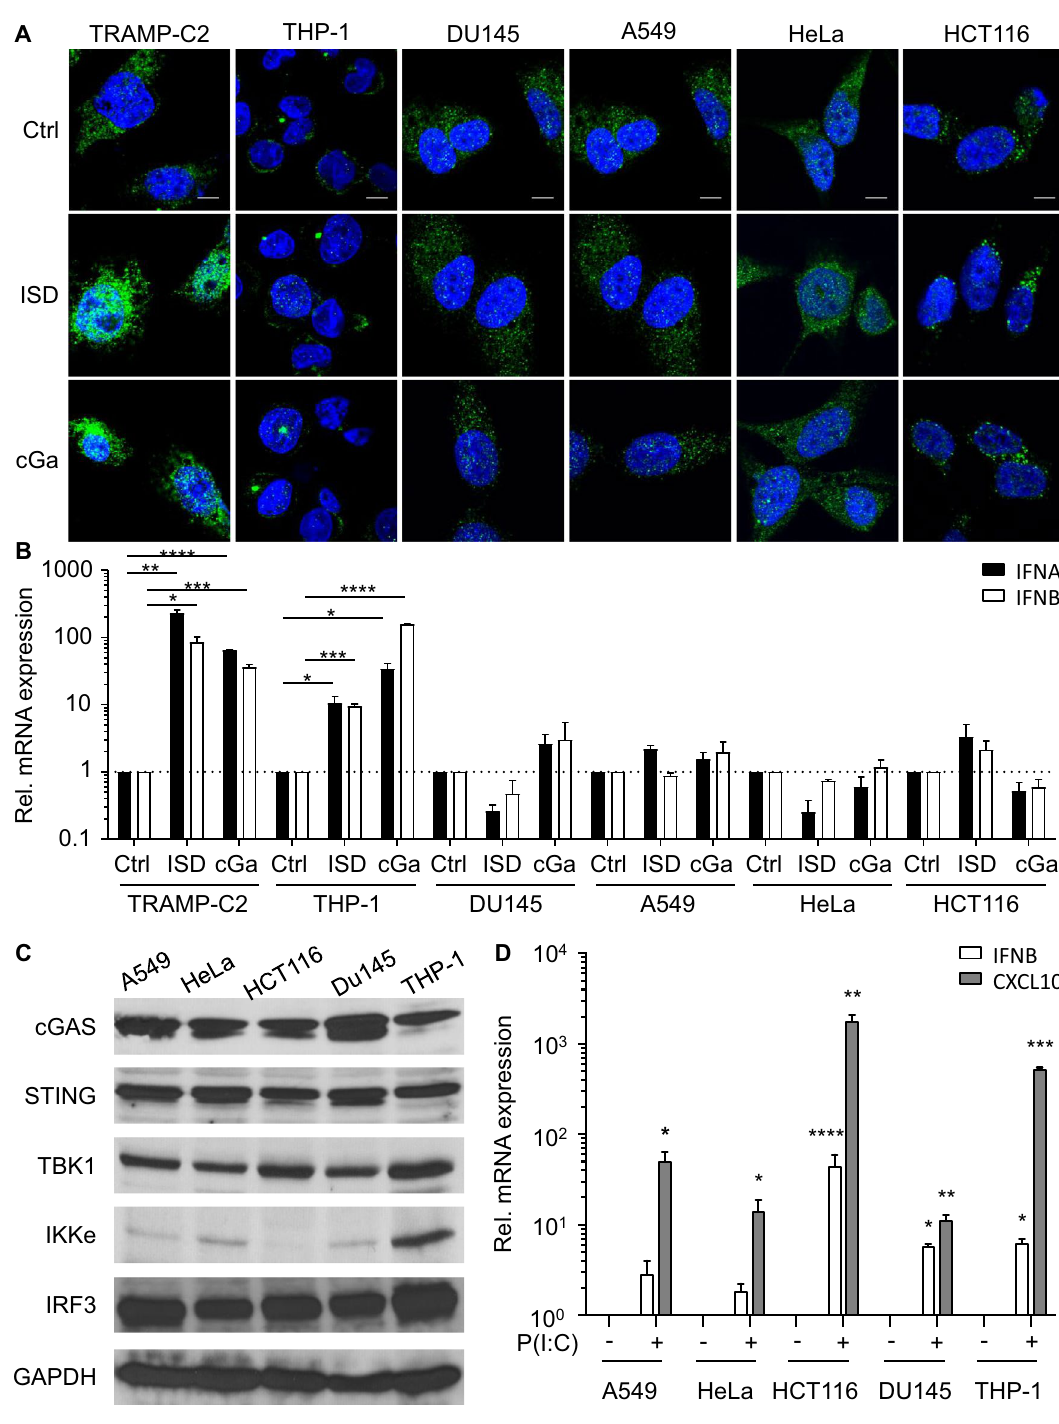
Figure 1. STING Signaling is Defective in the Majority of Tested Human Cancer Cell Lines. ( A ) Murine TRAMP-C2 prostate cancer cells, human THP-1 leukemia cells, human DU145 prostatic carcinoma cells, human A549 lung carcinoma cells, human HeLa cervical adenocarcinoma cells and human HCT116 colorectal carcinoma cells were treated with PBS (ctrl), 2 μg/ml ISD or 2 μg/ml cGAMP (cGa) for 4 h. Endogenous IRF3 expression (green) in treated cells was analyzed by confocal microscopy. Scale bar denotes 10 μm in all images. ( B ) TRAMP-C2, THP-1, DU145, A549, HeLa and HCT116 cells were treated with PBS (ctrl), 2 μg/ml ISD or 2 μg/ml cGAMP (cGa) for 4 h. Treated cells were analyzed for the endogenous expression of IFNA (black columns) and IFNB (white column) transcripts by real-time PCR. Expression values were normalized to PBS (ctrl)-treated cells. ( C ) Immunoblot analysis of cGAS, STING, TBK1, IKKe, IRF3 and GAPDH levels in A549, HeLa, HCT116, DU145 and THP-1 cells. The cell lysates were equally divided and loaded into different gels. The grouping of blots were cropped from different parts of the same gel, or from different gels. Data are representative of 3 independent experiments. ( D ) A549, HeLa, HCT116, DU145 and THP-1 cells were treated with 25 μM Poly(I:C) for 4 h. Treated cells were analyzed for the expression of IFNB (white columns) and CXCL10 (grey column) transcripts by real-time PCR. Expression values were normalized to mock-treated cells. Data are presented as mean ± SD of 3 independent